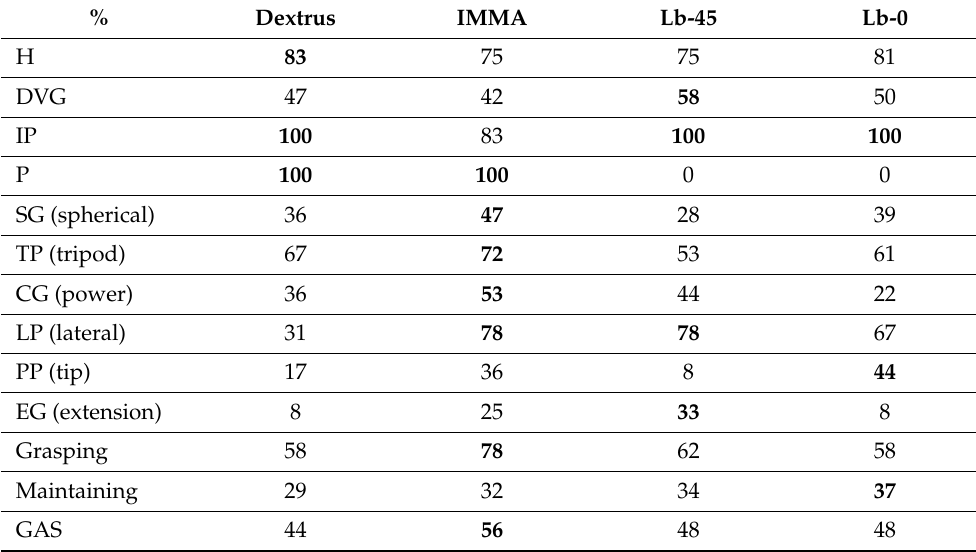
Table 3. AHAP scores, pGAS, for each GT. The maximum pGAS score for each GT is in bold. Overall, AHAP scores are listed at the